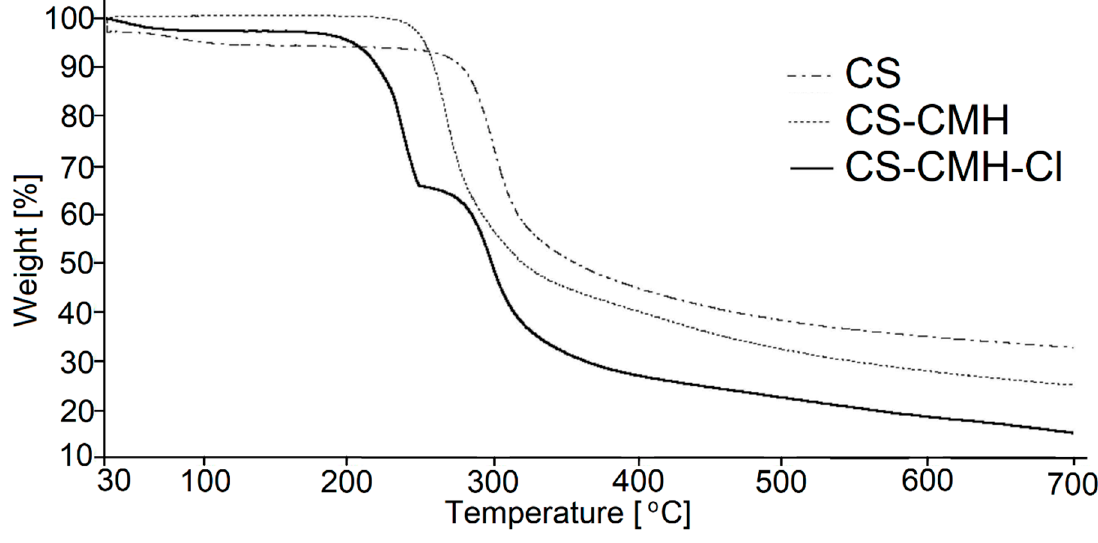
Figure 5. TG curves of the obtained chitosan films.